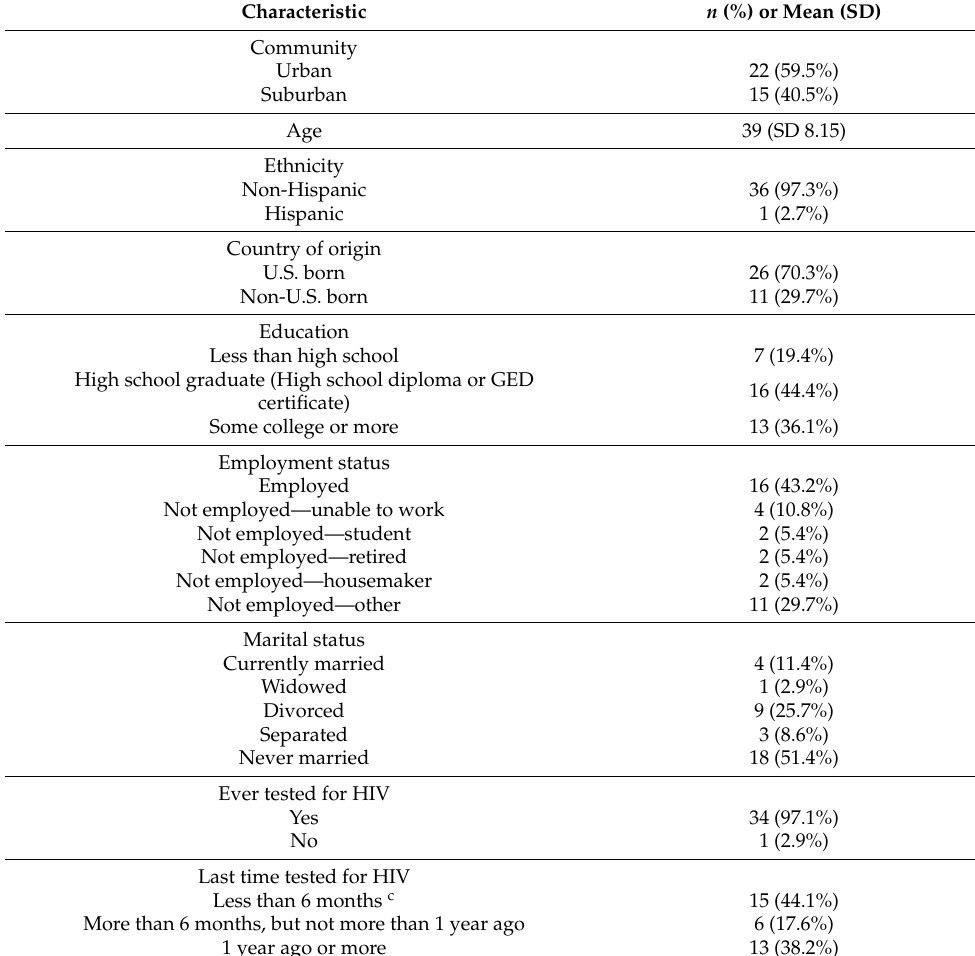
Table 2. Sociodemographic characteristics of Black and African American women ( n = 37) a,b .